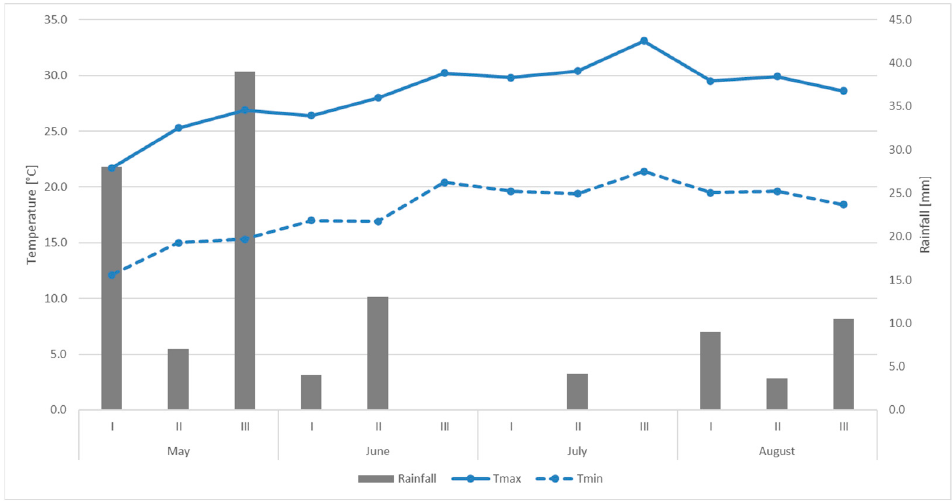
Figure 1. Mean maximum and minimum air temperatures and total rainfall during cropping cycle (9 May–12 August 2015).